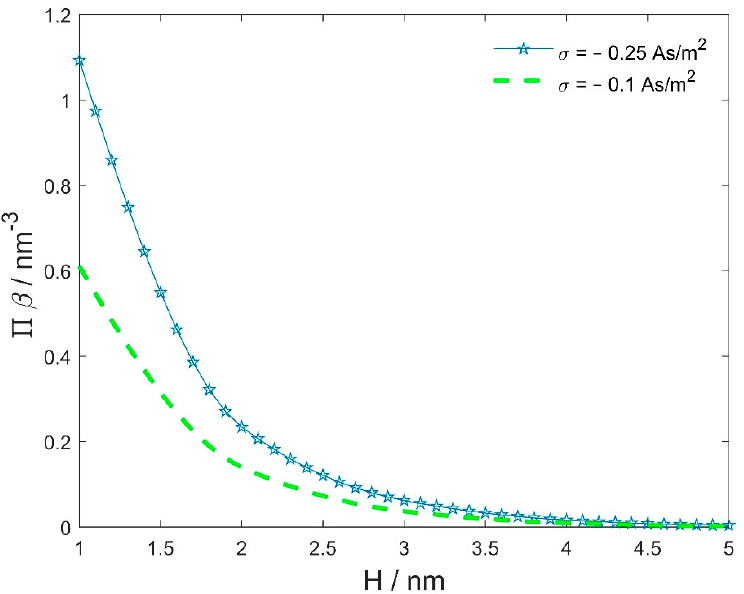
Figure 5. The calculated osmotic pressure between two negatively charged spherical vesicles of the same radius ( R p = R = 10 nm) and same surface charge density as a function of the distance between their surfaces ( H , see Figure 4). The values of the model parameters are n 0 / N A = 0.15 mol/L, n w / N A = 55 mol/L, and p 0 = 3.1